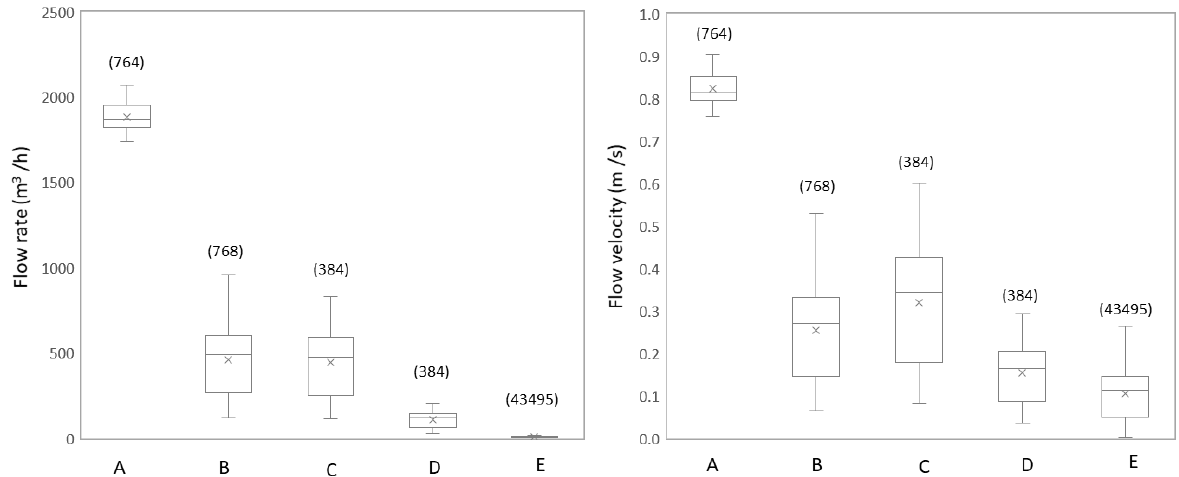
Figure 2. Changes in the flow rates ( left ) and flow velocities ( right ) from the treatment effluent (A) and four locations over the water transport (B–D) and distribution (E) trajectory. Box plots show the first, second (median), and third quartiles, whiskers show the data range, circles show outlier values, and a cross (x) indicates the mean value. The number of measurements are shown in brackets.